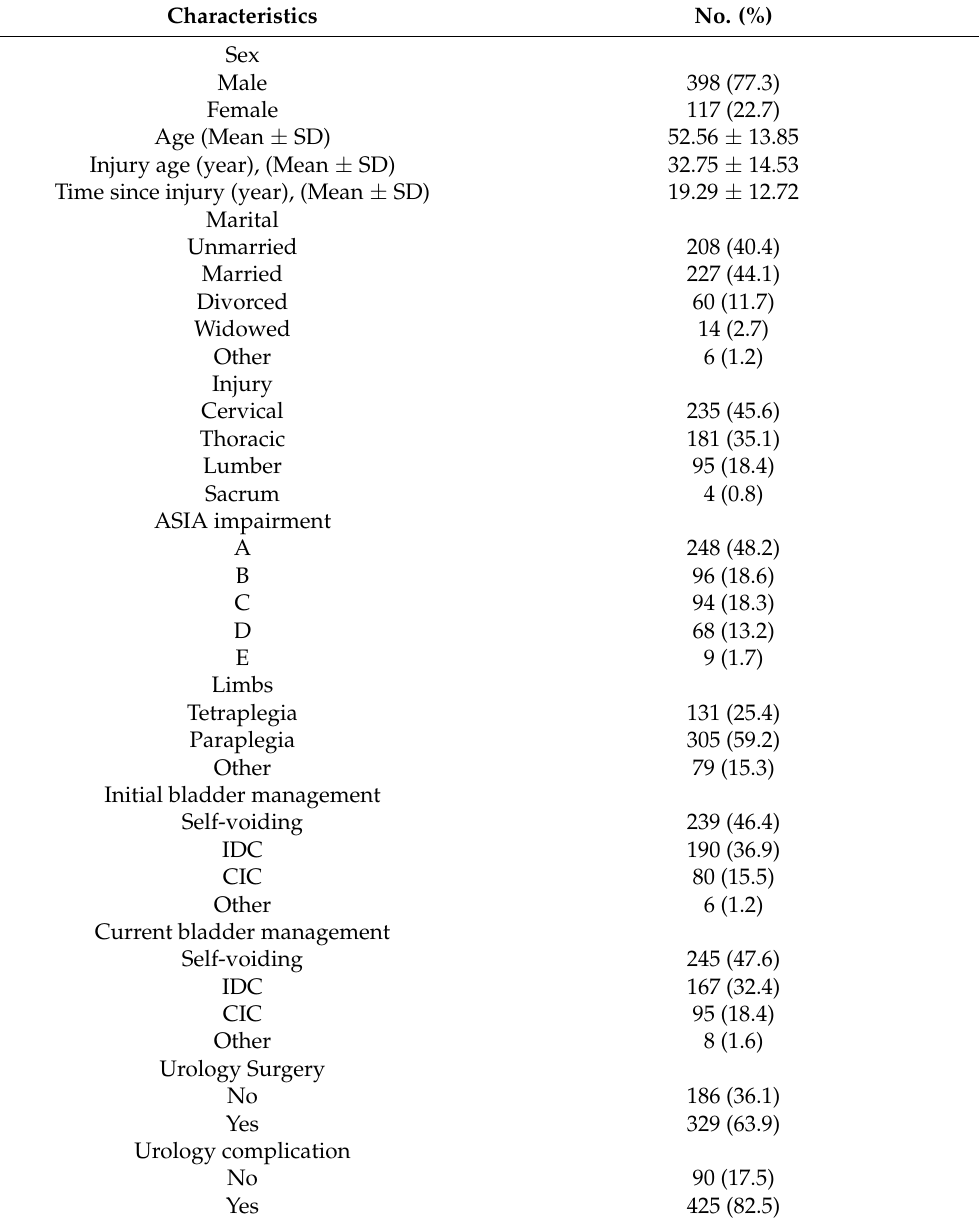
Table 1. Demographic and injury characteristics of 515 patients with spinal cord